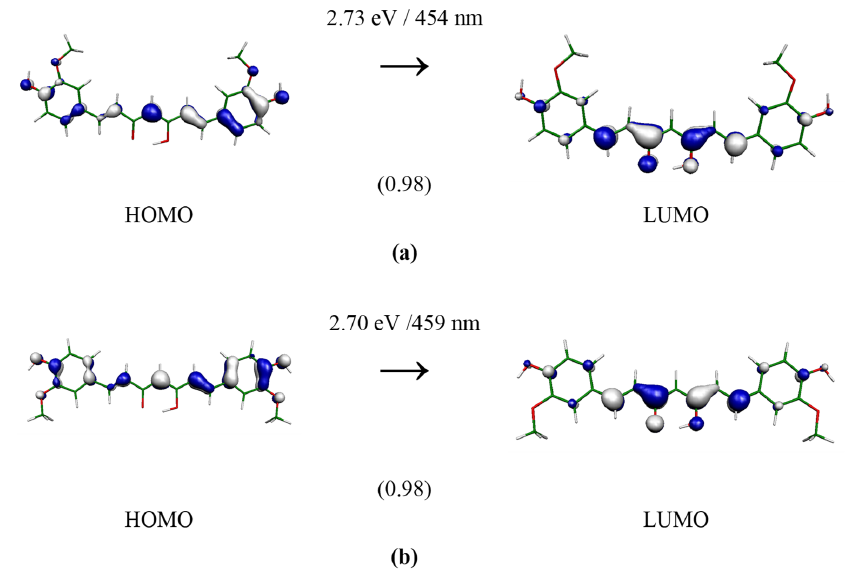
Figure 4. TD-B3LYP(SMD = water)/aug-cc-pVDZ//M062X/cc-pVDZ electron transition forming 1 1 A’ state of curcumin keto-form Iia ( a ) and Iib ( b ) of C s group. The depicted orbital isosurface is 0.05 a.u. The oscillator strengths (in atomic units) are in parentheses.